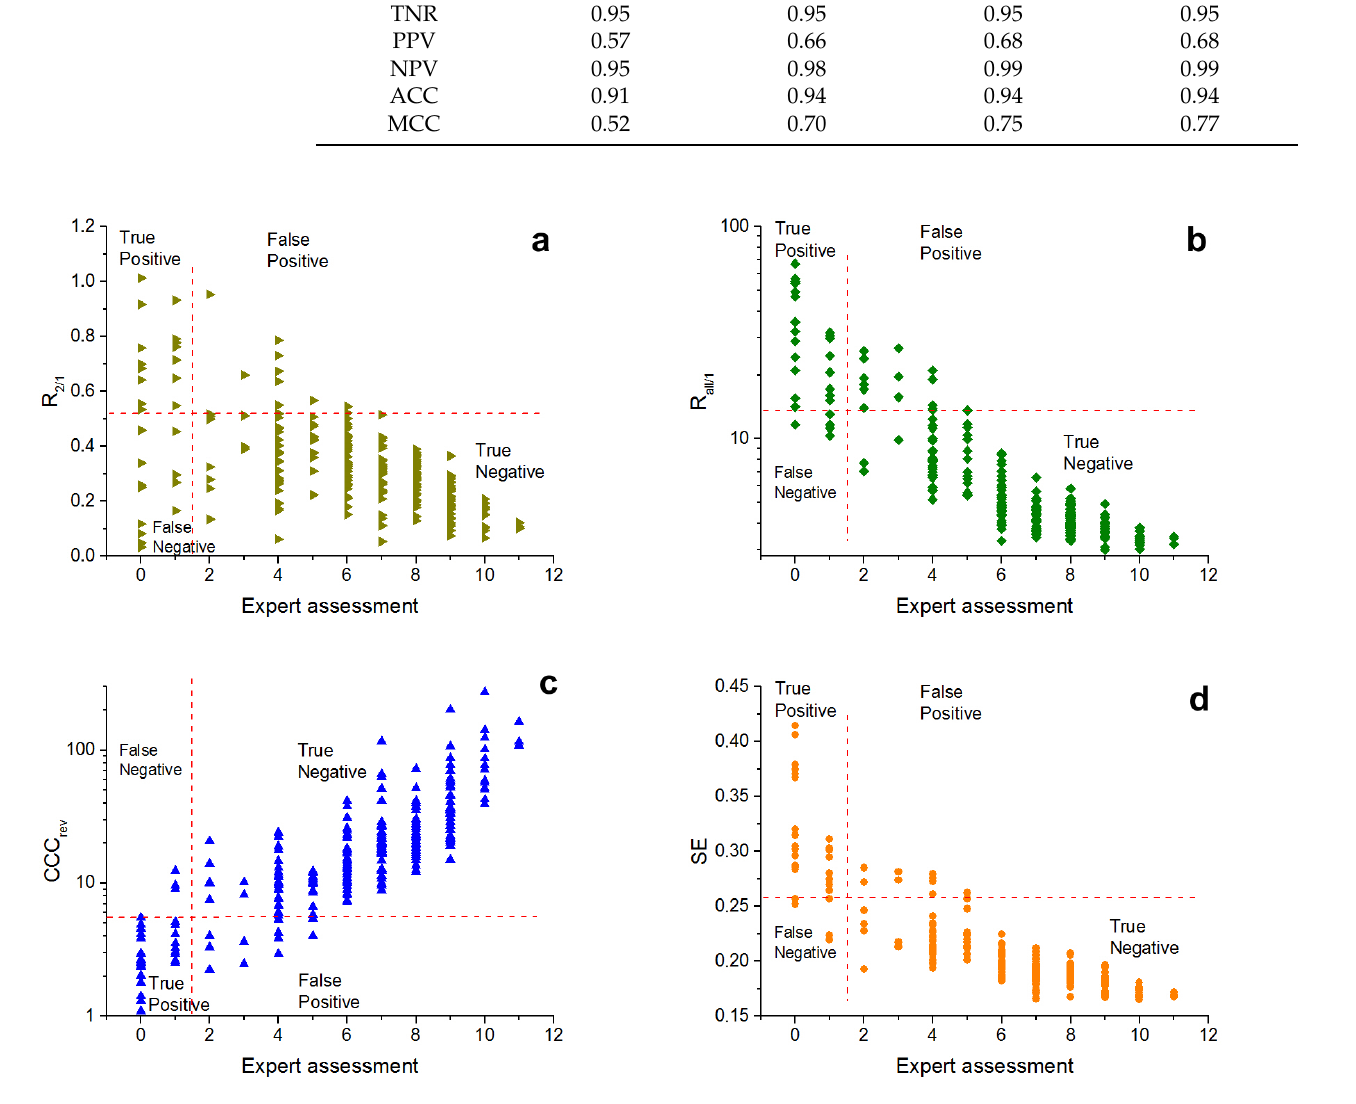
Figure 9. Distribution of the texture metrics in accordance to the expert assessments: R 2/1 ( a ), R all /1 ( b ), CCC rev ( c ), SE ( d ). Thresholds are given for hypothesis 2